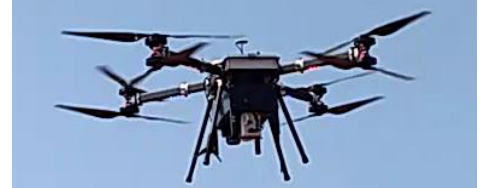
Figure 2. SX8 UAV and its